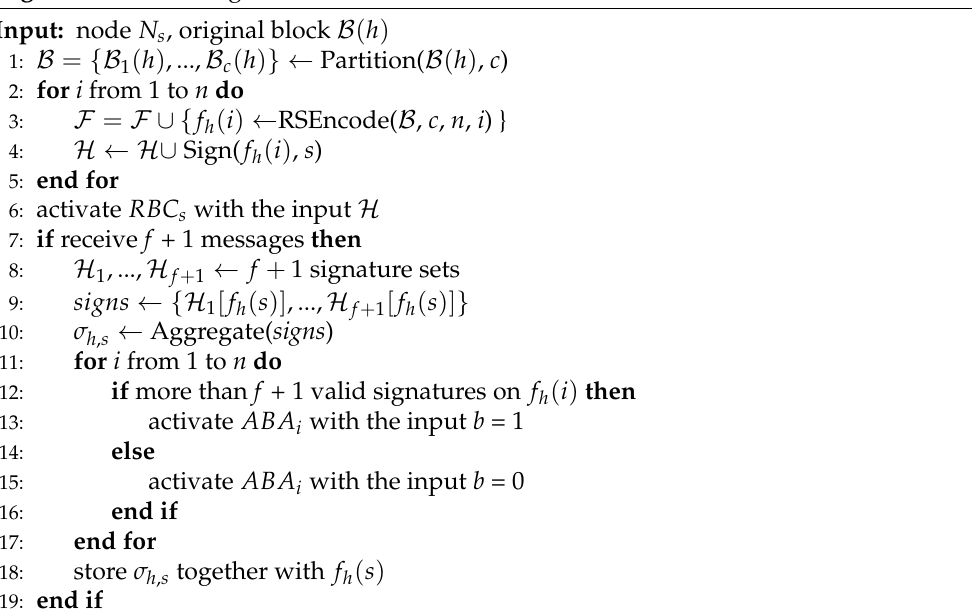
Algorithm 1 Encoding and Consensus in